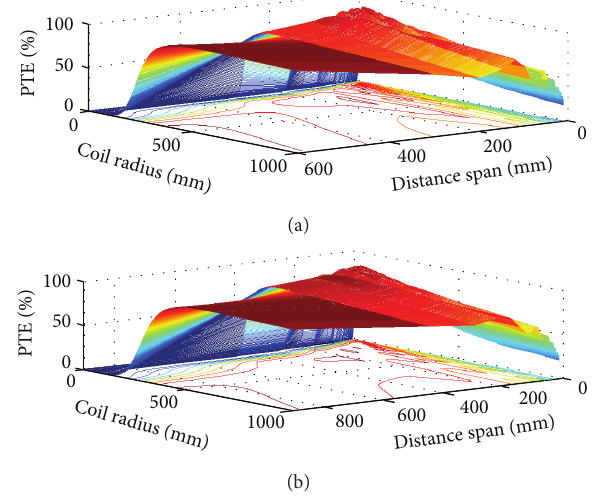
Figure 7: PTE versus coupled resonator coil radius and distance span. (a) DCR configuration scenario A. (b) DCR configuration scenario